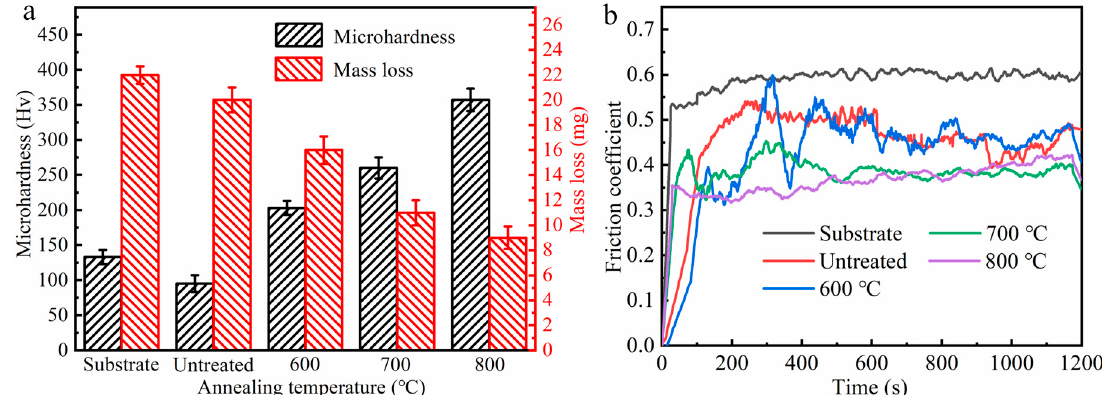
Figure 6. The surface tribological properties of the Ni/Cu/Ni coatings after annealing at various temperatures: ( a ) microhardness and mass loss and ( b ) the change curves of the friction coefficient with sliding time.